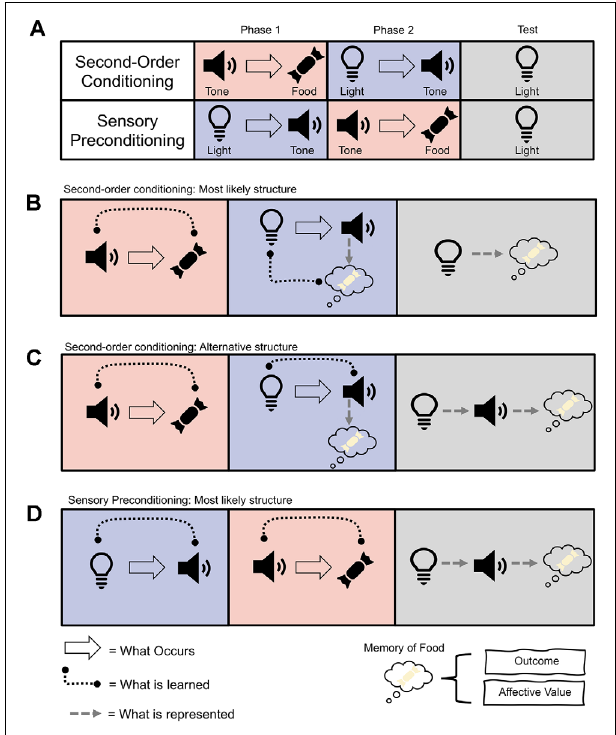
FIGURE 1 | (A) Example procedures for second-order conditioning (SOC) and sensory preconditioning (SPC). (B) Most likely associative structure underlying SOC, whereby the light becomes directly associated with a memory of the food and its affective value or sensory-specific representation. (C) Alternative associative structure of SOC whereby light is associated with the tone, which is associated with the memory of the food and induces a response. (D) Most likely associative structure of SPC whereby the light is associated with the tone, which is associated with a memory of the food and involves the hippocampus and orbitofrontal cortex